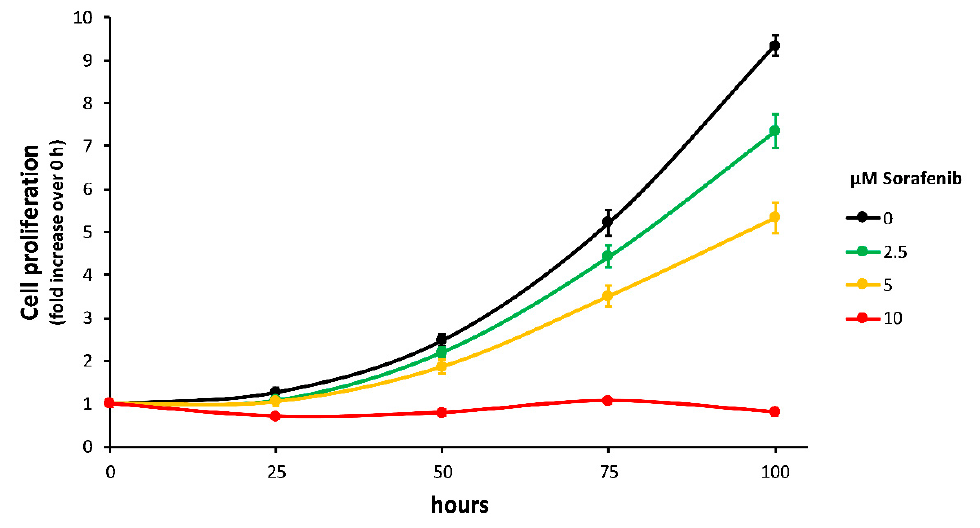
Figure 4. Traditional crystal violet cell proliferation assay. HLF cells were seeded and treated with scaled concentrations of Sorafenib . At the indicated time points, the cells were fixed and stained with crystal violet dye. Proliferative index was normalized to time = 0 h.